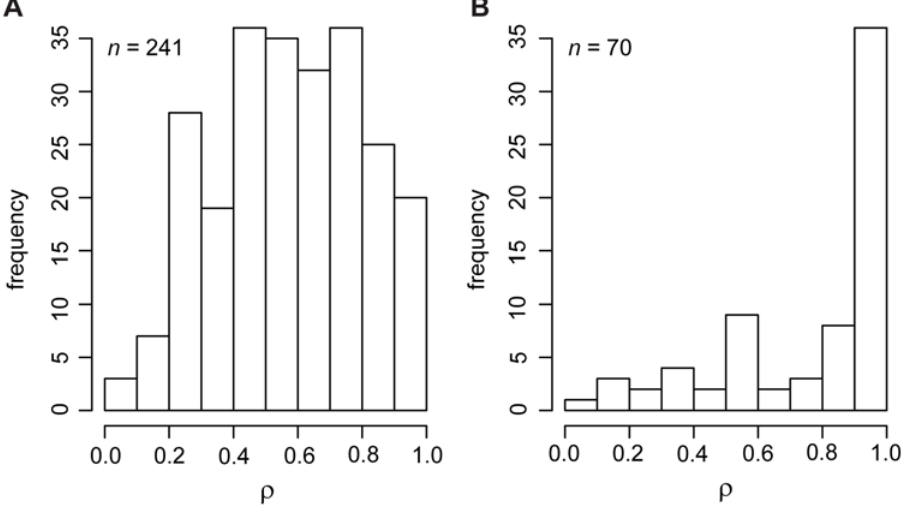
Figure 3. Relationship between r and domon coverage of the genes. Two instances are shown, when domon coverage on the aligned gene sequence is (A) greater than or equal to 80%, or (B) less than 80%, of the total sequence length. The sample size in each distribution ( n ) is shown in the top left corner of the panel. Large r values < 1 suggest that the respective recombination breakpoint locates at or outside the domon boundary, avoiding disruption of the domon